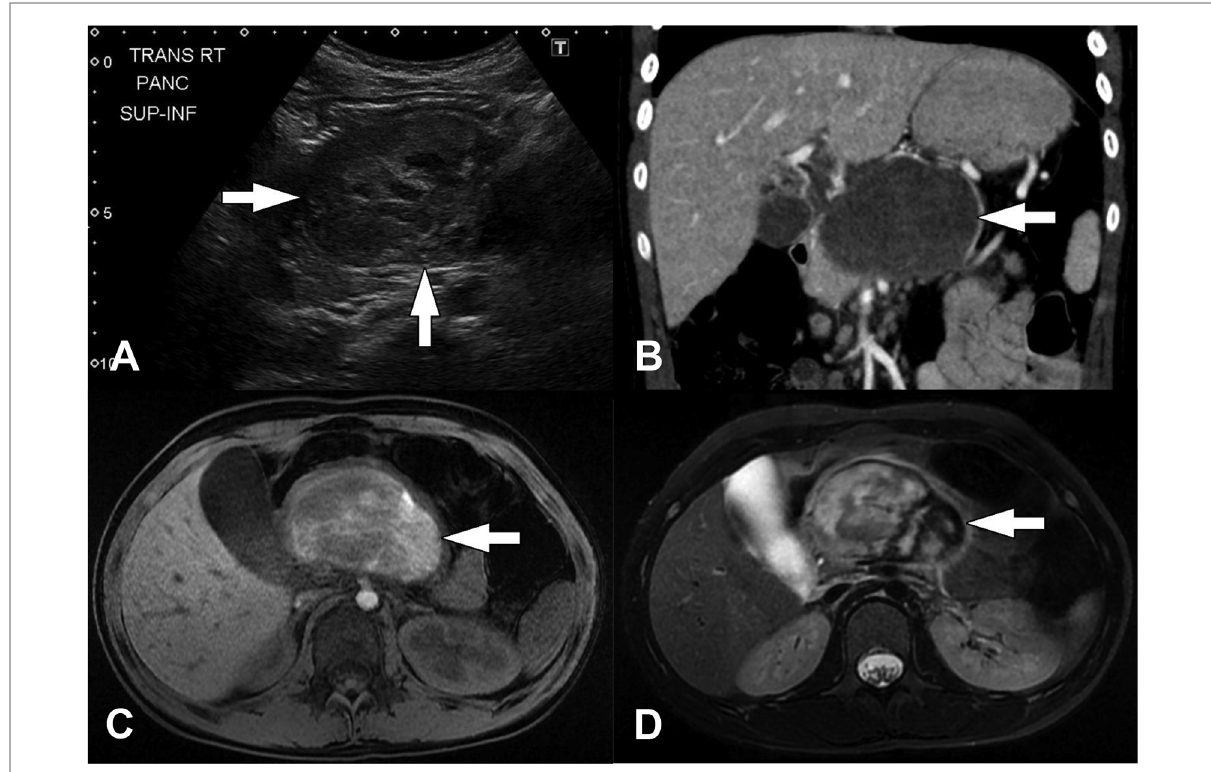
FIGURE 3 Solid pseudopapillary neoplasm. ( A ) Transverse image from initial transabdominal ultrasound shows a heterogeneous mass (arrows) in the expected location of the pancreas. ( B ) Coronal reformatted image from subsequently performed CT of the abdomen obtained in the portal venous phase following intravenous contrast material administration shows a heterogeneously hypoattenuating mass arising from the body of the pancreas (arrow). Subtle enhancing septations/material are visible within the mass. ( C ) Axial T1-weighted and ( D ) axial T2-weighted images from subsequently performed MRI show the mass in the body of the pancreas (arrows). The mass is internally heterogeneously T1-weighted and T2- weighted hyperintense with prominent peripheral T2-weighted hypointensity. These signal characteristics suggest the presence of internal